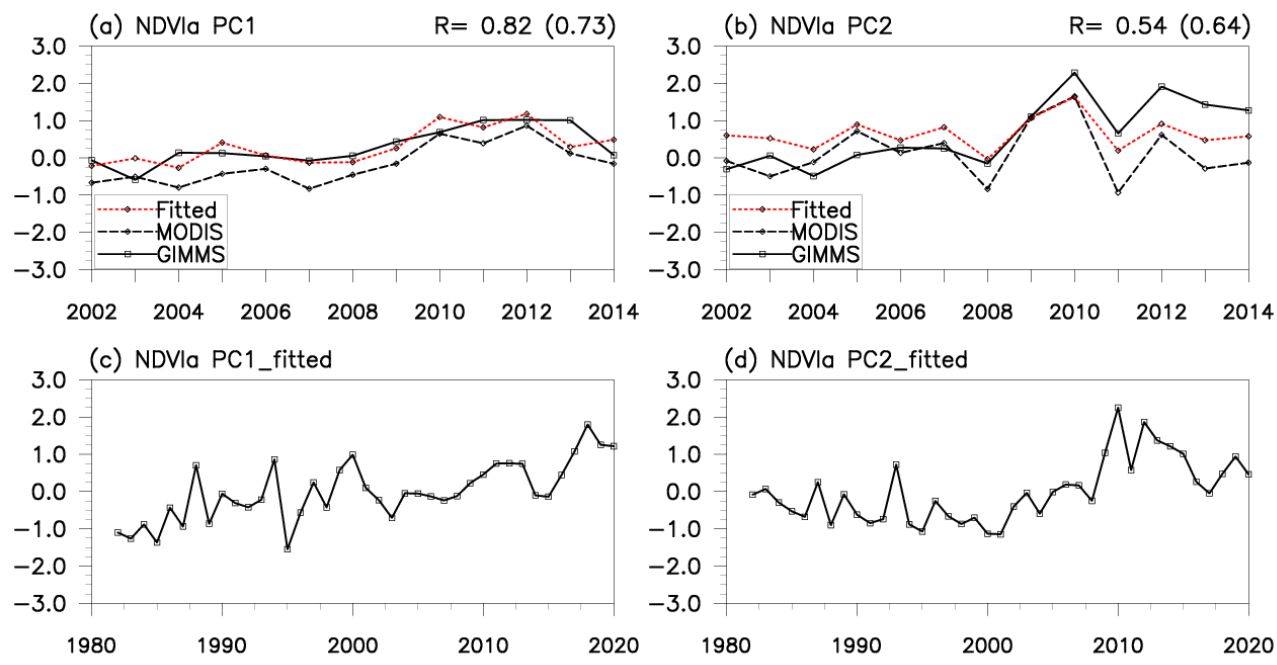
Figure 3. ( a ) The time series of PC1 during the period 2002–2014, in which the black solid, black dashed, and red dashed lines represent the GIMMS- and MODIS-based PC1, respectively. ( b ) as in ( a ), but for the time series of PC2. ( c ) The time series of the fitted and spliced PC1 during the period 1982–2020. ( d ) as in ( c ), but for the time series of PC2.